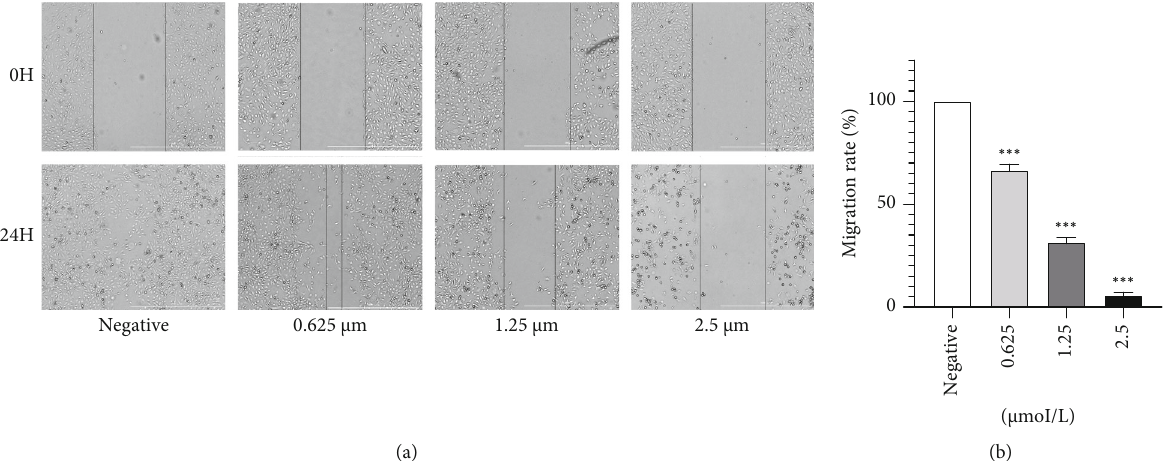
Figure 3: E ff ect of anlotinib on cell migration evaluated by wound healing assays in HSC-3 cells. The results are from three independent experiments ∗∗∗ P < 0 : 001 . (a) E ff ect of anlotinib on cell migration evaluated by wound healing assays in HSC-3 cells. (b) E ff ect of anlotinib on the migration of HSC-3